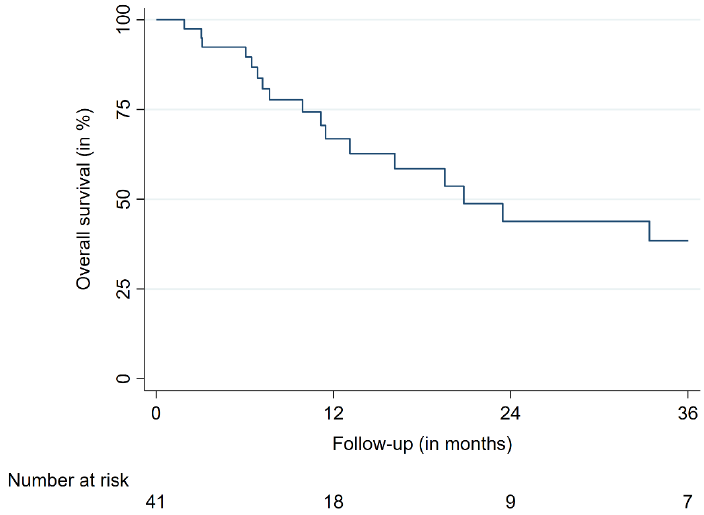
Figure 1. Overall survival.